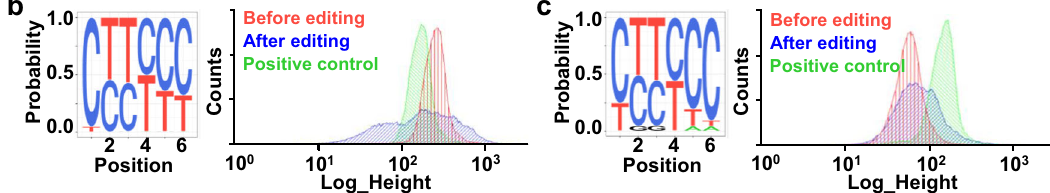
TTTTCTCCACATAAGCTGGCAATGTTGCGACGCAACAGGTACAGTGTAATTCAGGAGAAAATCGCACCGGA